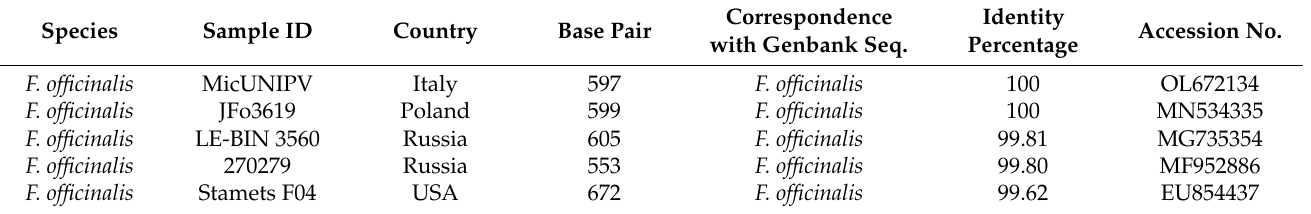
Table 1. GenBank sequences and identity percentages with Fomitopsis officinalis strain (PeruMyc 3897) studied in this work.